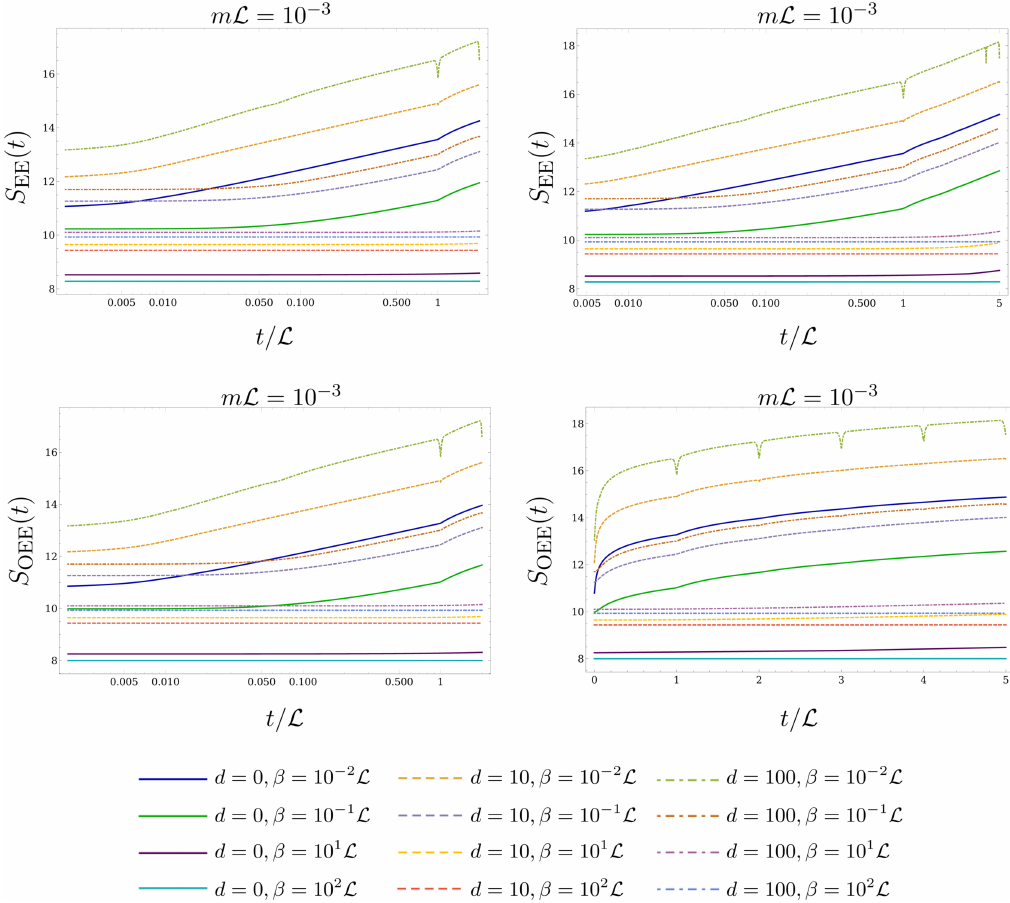
Figure 15 . Temperature effect for disjoint configurations. The time evolution of S EE and S OEE are presented for various temperatures and various subregion distances. We take N =1501 , N + N =1+1 N A A L 2( R 2) L 1( R 1)